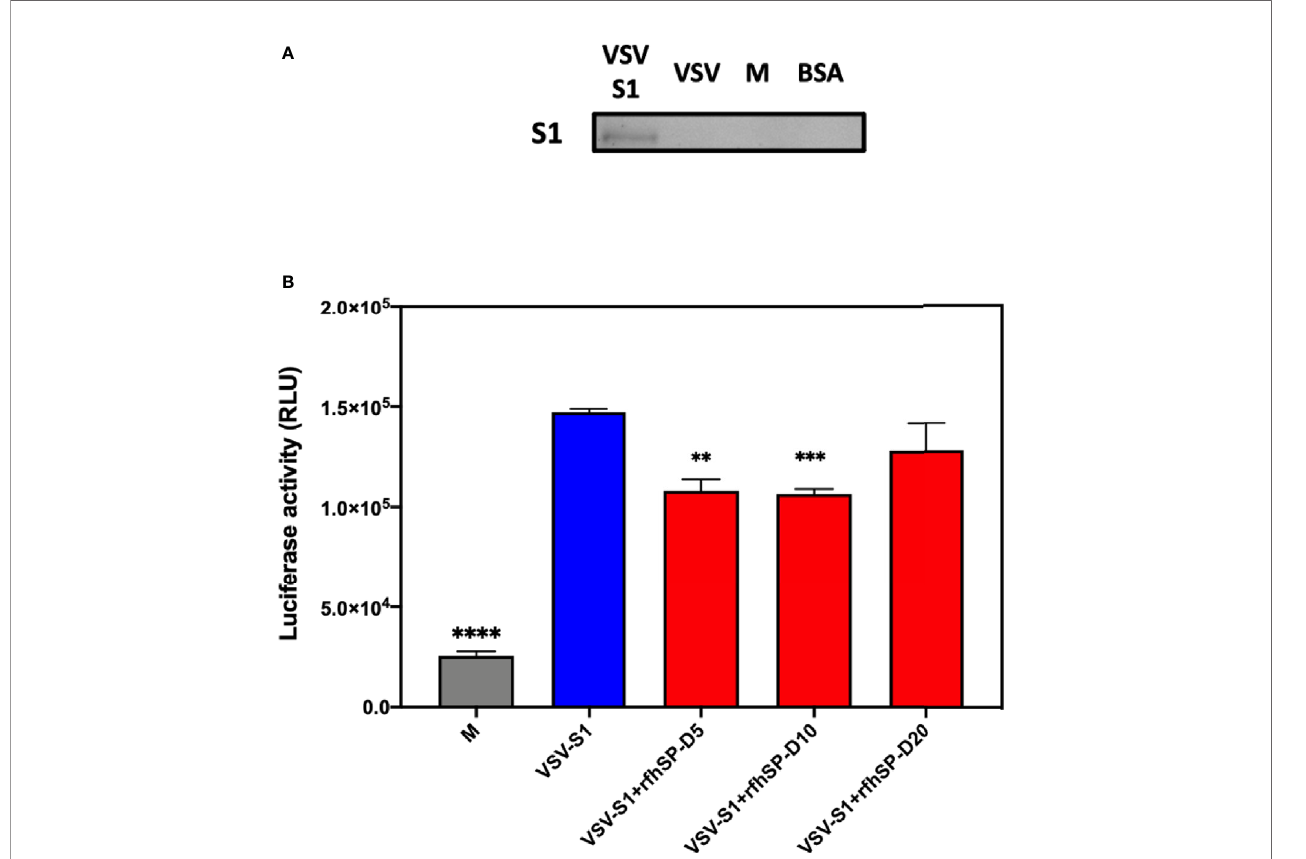
FIGURE 5 | rfhSP-D acts as an entry inhibitor of SARS-CoV-2 infection. (A) The SARS-CoV-2 pseudotyped lentiviral particle and pseudotyped lentiviral particle containing medium were determined the S1 expression by western blotting. (B) Luciferase reporter activity of rfhSP-D treated HEK293T cells (overexpressing ACE2 receptor) transduced with of SARS-CoV-2 S1 pseudotyped lentiviral particles. Signi fi cance was determined using the unpaired t test statistical analysis. All groups compared to VSV-S1. The error bars show SEM. M=medium (**p<0.01; ***p<0.001; ****p<0.0001) (n =